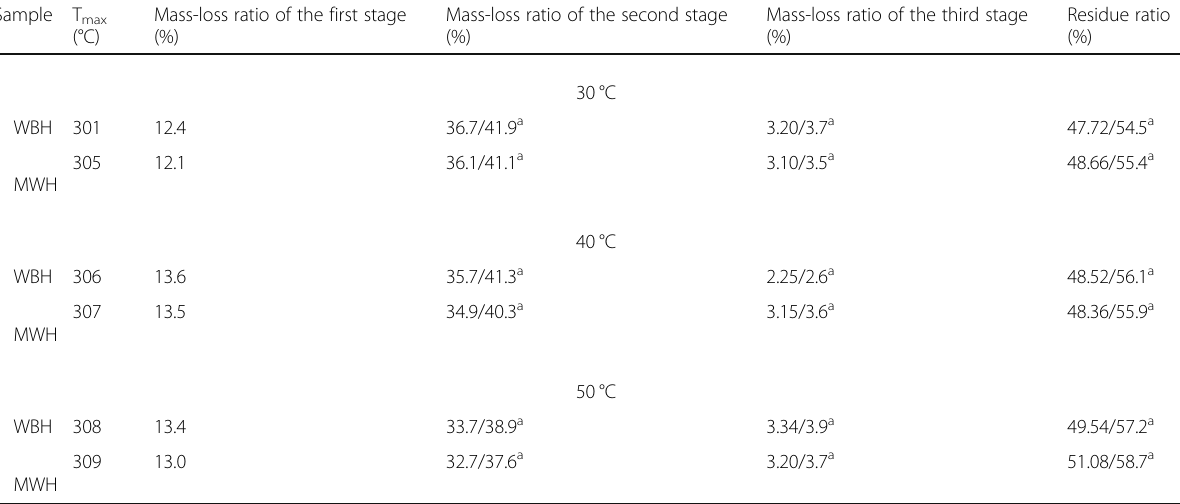
Table 2 TG analysis of tanned hide powder obtained under different heating methods Sample T max